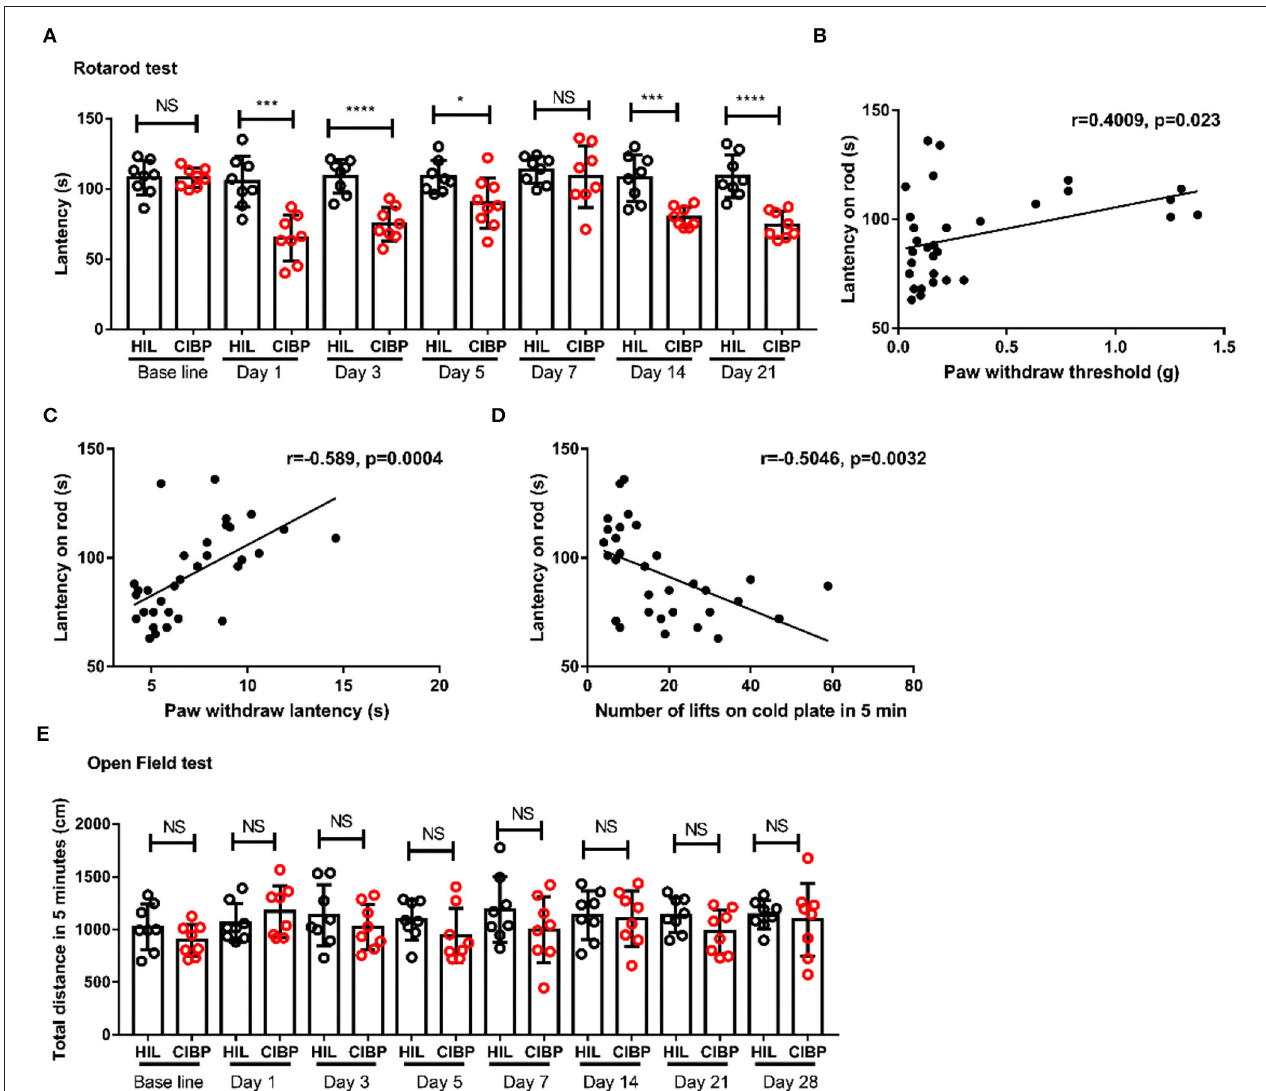
FIGURE 2 | Motor coordination and balance were impaired in mice with CIBP surgery. (A) The latency in rotarod tests between the HIL and CIBP groups. n = 8 mice/group. (B) Linear analysis of motor coordination with mechanical allodynia. (C) Linear analysis of motor coordination with hot allodynia. (D) Linear analysis of motor coordination with cold allodynia. (E) The motion distance compared between the HIL and CIBP group in the open field test. n = 8 mice/group. * P < 0.05, *** P < 0.001, **** P < 0.0001 by two-way (A,E) repeated measures ANOVA followed by post-hoc